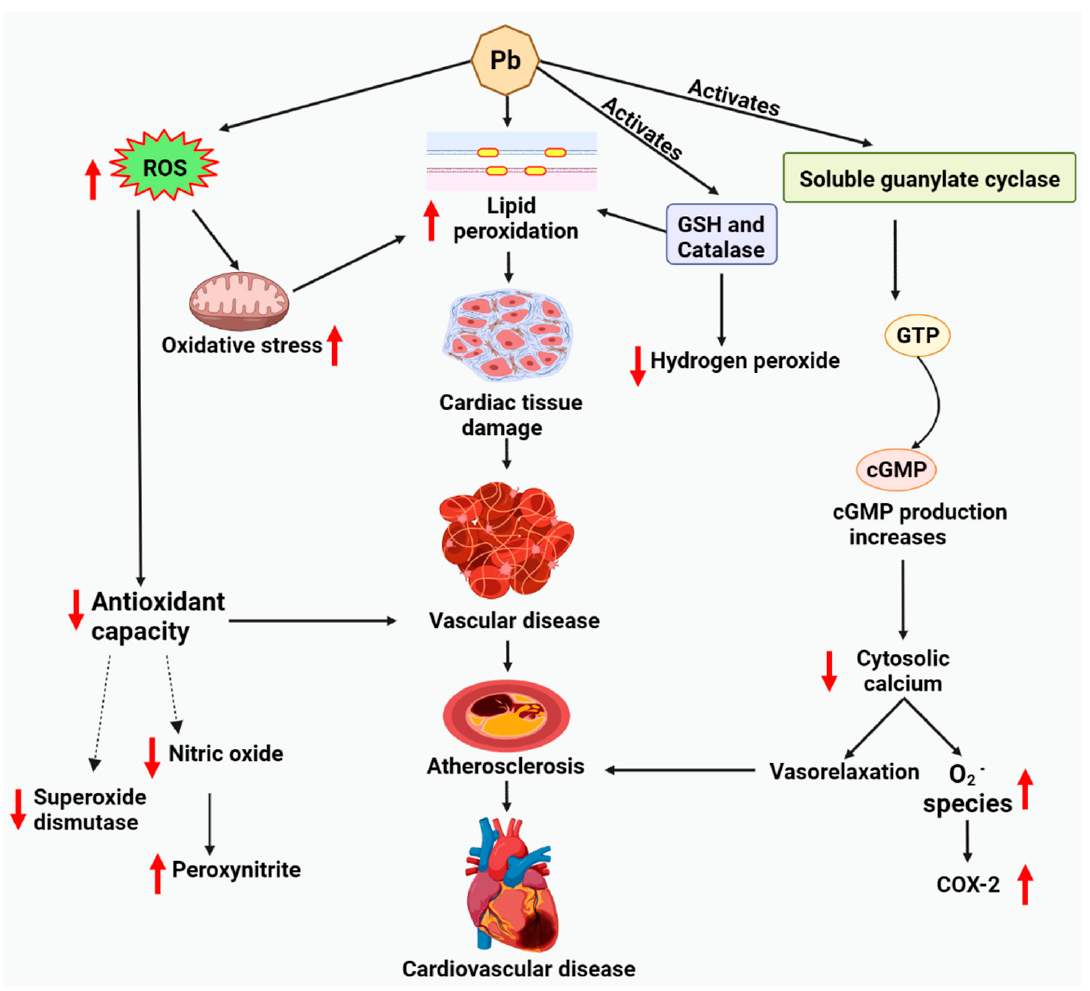
Figure 4. Lead-induced lipid deregulation via cardiac tissue damage and cardiotoxicity. Lead generates ROS, resulting in oxidative stress on the cell and decreasing the antioxidant and cytosolic calcium levels. Lead exposure also upregulates lipid peroxidation implicated in the cardiotoxicity process. Abbreviations: cGMP, cyclic guanosine monophosphate; COX, cyclooxygenase; GSH, reduced glutathione; GTP, guanosine-5’-triphosphate; ROS, reactive oxygen species.